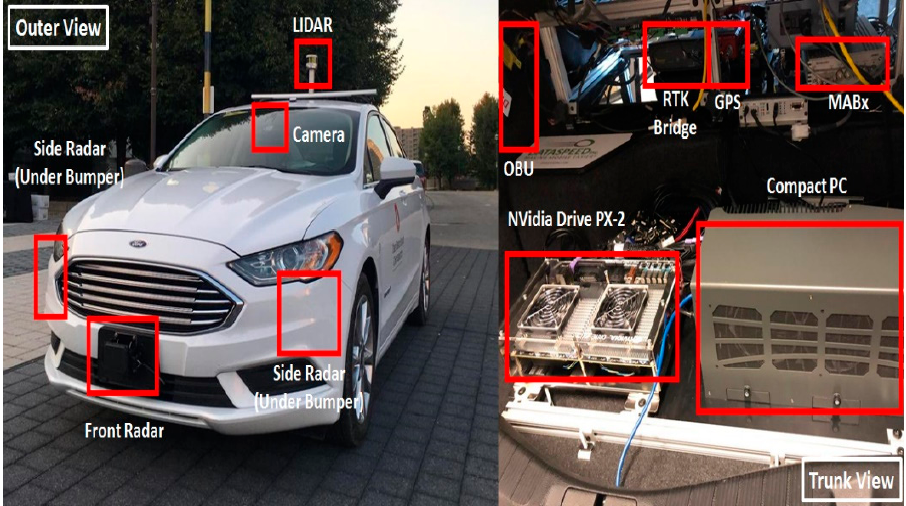
Figure 4. CAV platform equipped with hardware.